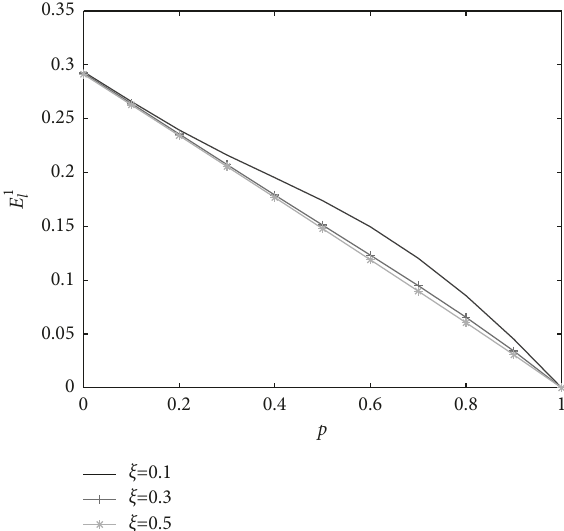
Figure 4: Effect of p on mean number of lost customers due to i for various im- customer impatience E 1 l for various impatient rate ξ .